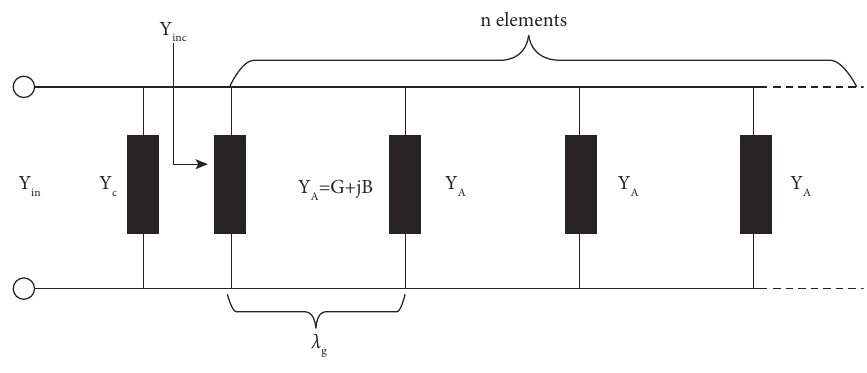
Figure 10: Equivalent circuit of row array.